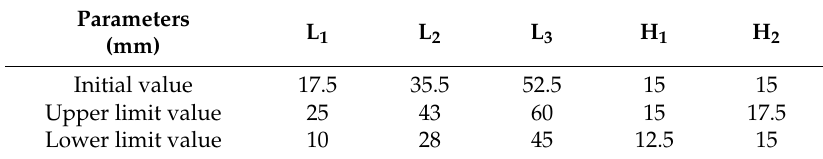
Figure 17. Geometric parameters of the cooling plate (1/4). Table 8. Geometric parameters of the cooling plate.